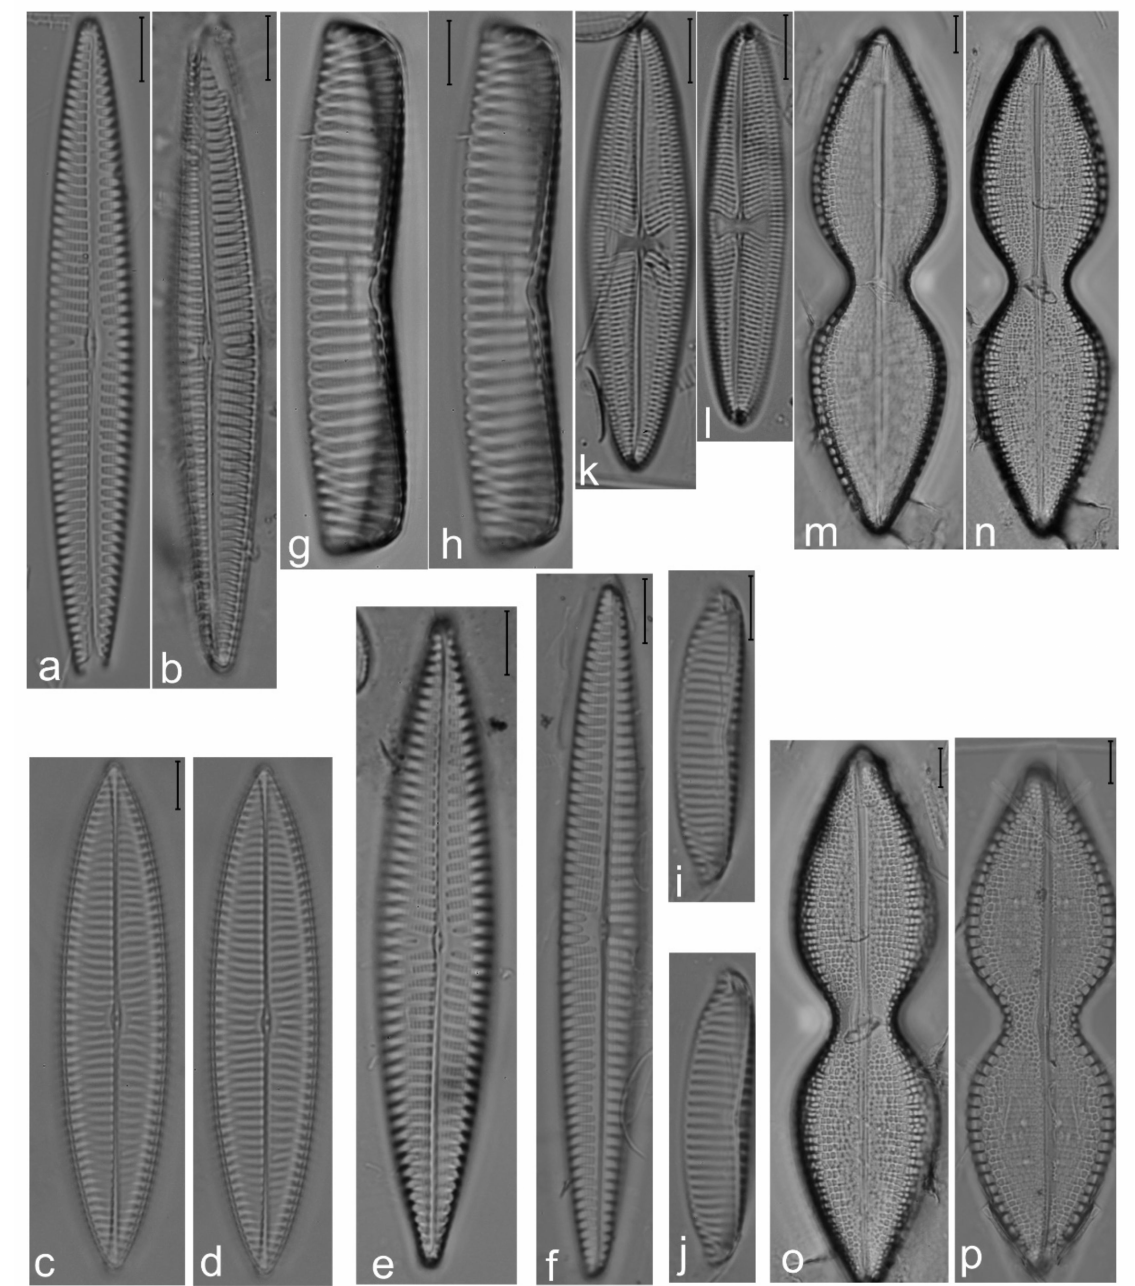
Figure 16. ( a , b ) Navicula longa var. irregularis ; ( e , f ) N . longa var. longa ; ( c , d ) N . transitans ; ( g , h ) N . pennata ; ( i , j ) N . bipustulata ; ( k , l ) Trachyneis aspera ; ( m – p ) Dictyoneis marginata var. maxima in different focal planes. Scale bar = 10 µ